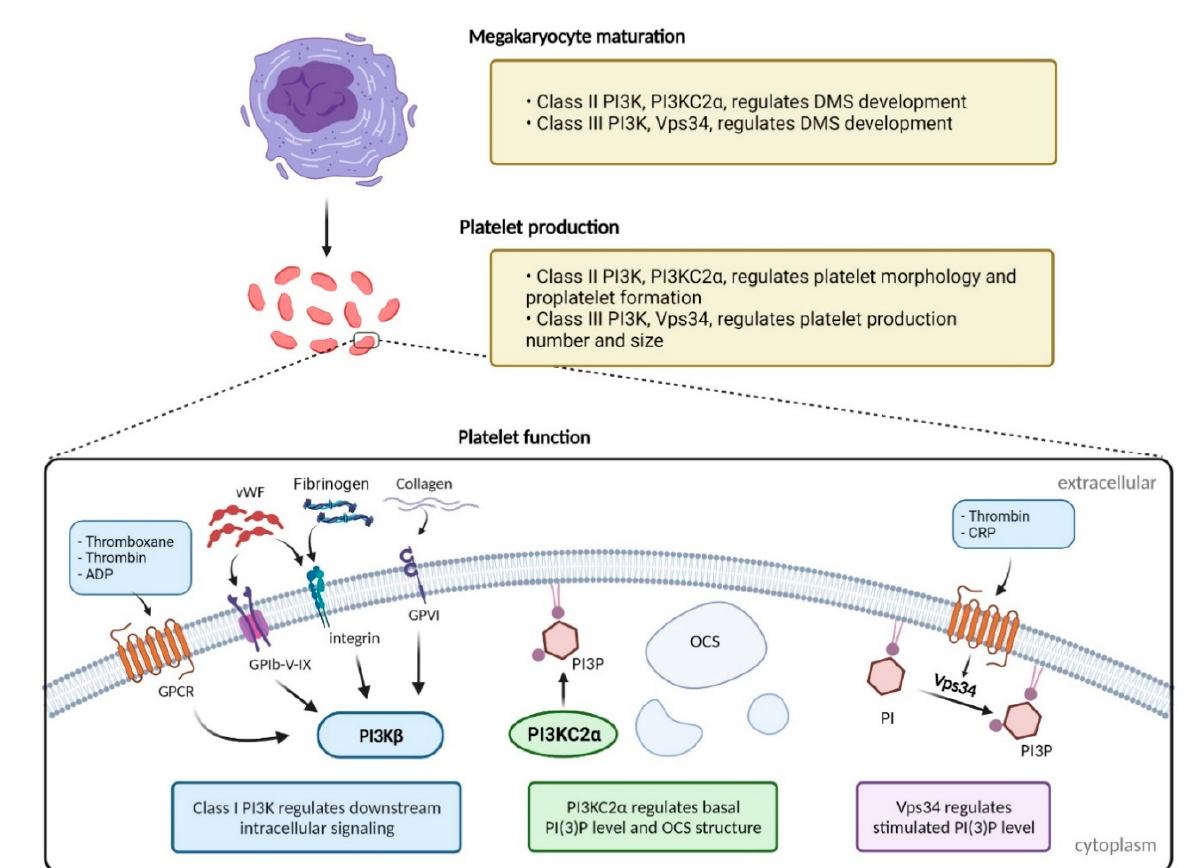
Figure 1. The function of PI3K isoforms in megakaryocytes and platelets. The sole Class III PI3K, Vps34, plays important roles in both platelet production and function while specific Class I and Class II isoforms are more selectively involved in platelet function. The Class I PI3K, PI3K β , is involved in intracellular signalling downstream of many platelet surface receptors including GPCRs and integrins and contributes to the platelet activation mechanisms that support thrombus growth and stabilisation. The Class III isoform, Vps34, appears largely responsible for forming PI3P (and its subsequent intracellular signalling events) in response to GPCR activation. In contrast, the Class II isoform, PI3KC2 α , does not phosphorylate PI into PI3P in response to agonist activation but rather maintains basal PI3P levels and regulates the internal cell membrane (OCS) structure. OCS = open canalicular system; DMS = demarcation membrane system; GPCR = G protein coupled receptor; vWF = von Willebrand factor; CRP = collagen-related peptide. Figure created with BioRender.com. As the clinical development of the PI3K β inhibitor for thrombosis has halted, it opens the door for the potential use of Class II and III PI3K inhibitors. Deficiency in Class I and III PI3K isoforms leads to measurable defects in in vitro platelet functional response to various agonist, as seen in aggregation and activation assays [52,55,63,64,66,97]. This might indicate that targeting these classes might still not be able to fully discriminate thrombosis from haemostasis, as has been observed with the bleeding tendencies after the use of PI3K β inhibitor, TGX-221 [61] and mild bleeding defect in the AZD6482 clinical trial [54]. In contrast, targeting the Class II PI3K, PI3KC2 α , either genetically or pharmacolog- ically, appears to have no measurable effects on readouts of global platelet function meas- ured by platelet aggregation, integrin activation, and granule release [83,87]. The limited mechanistic studies available so far suggest that the anti-thrombotic effect associated with genetic or pharmacological PI3KC2 α deficiency is specific to shear-dependent platelet– platelet interaction [83,84,87]. It is likely that the impaired thrombus formation seen in PI3KC2 α deficiency is correlated with its function to maintain basal PI(3)P levels and its role in regulating platelet internal membrane (OCS) [83,86], rather than modulating intra- cellular signalling as seen for Class I PI3K and also with traditional antiplatelet therapy. In contrast, deficiency in the other isoform of Class II PI3K, PI3KC2 β does not impact